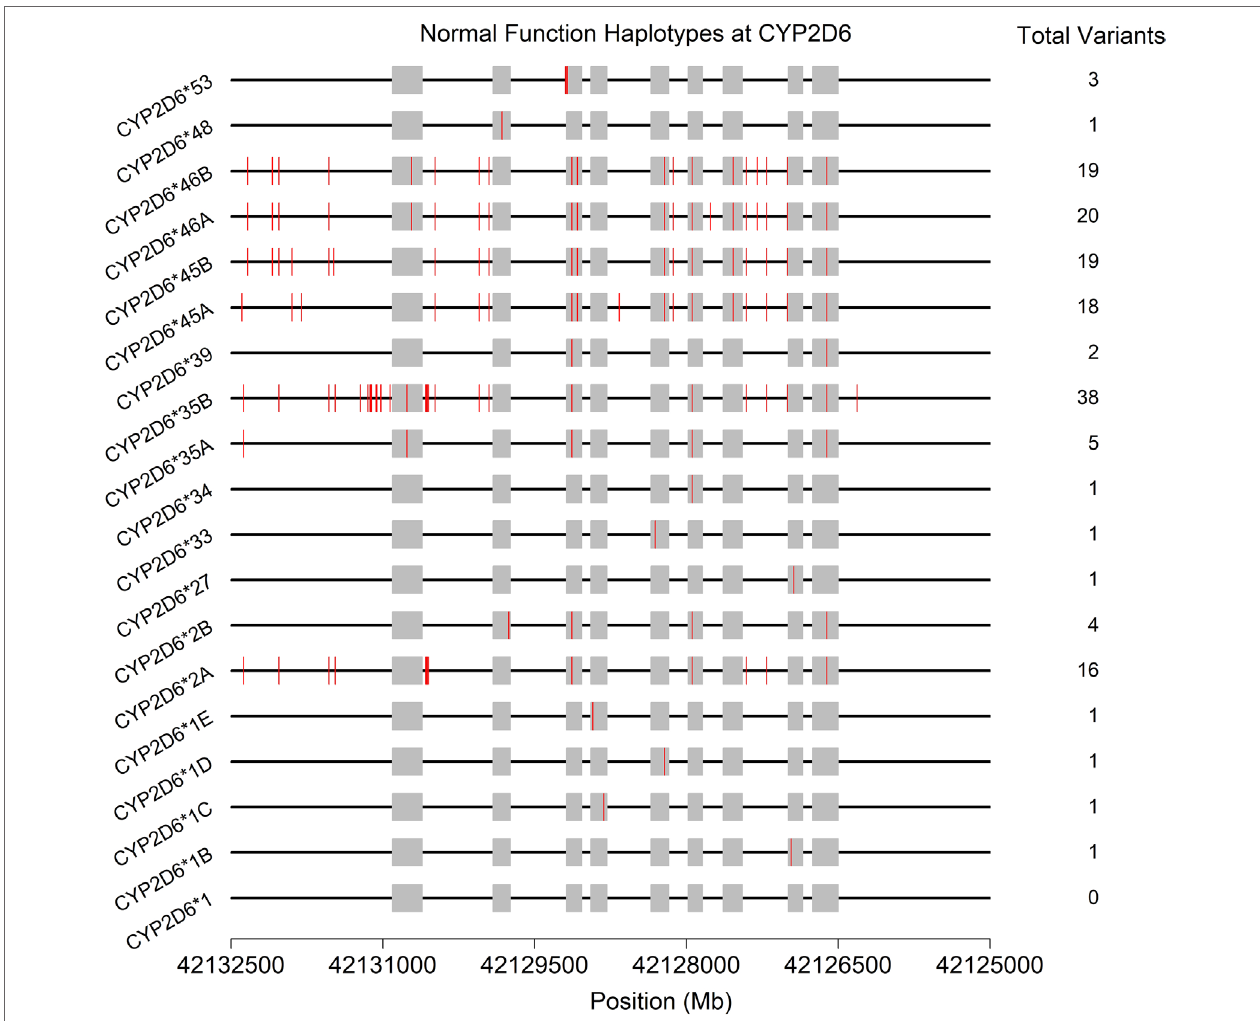
FIGURE 3 | Physical positions (red vertical lines) and total number of variants found on the 19 haplotypes (* alleles) predicted to produce normally functioning enzymes upon transcription/translation. See also Supplemental Figures 1–4 . Gray boxes indicate the exons (genome build